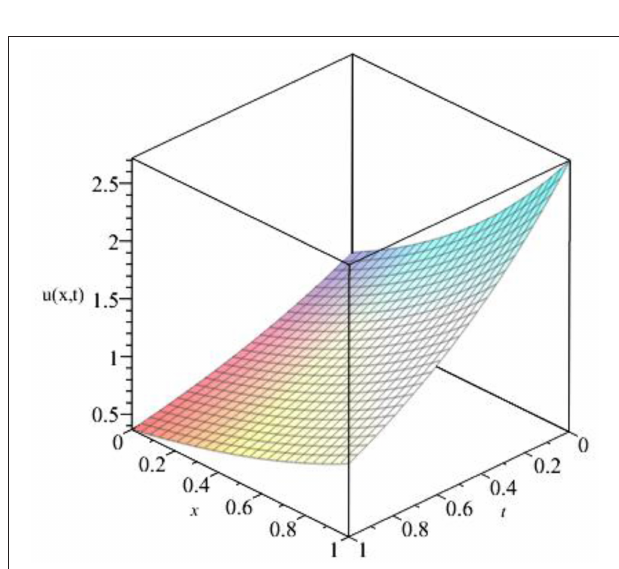
FIGURE 1 | Surface represents eight order approximate solution for α Ex. 5.1.